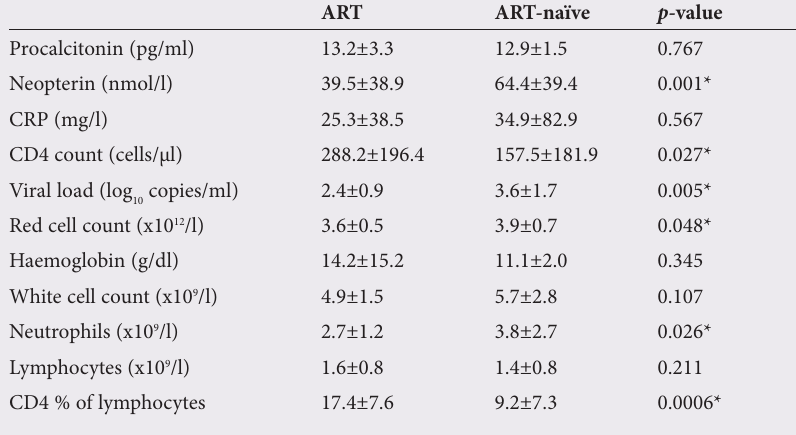
Table 2. Comparison of baseline blood measurements for the two